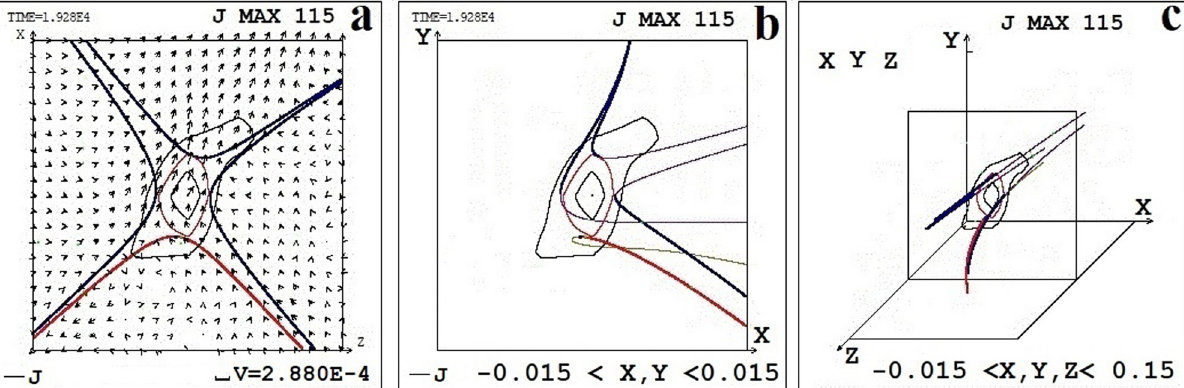
Figure 9: The con fi guration of the magnetic fi eld and the plasma fl ow in a region with a linear size of 0.03 ( 12 mm ) in the center of which the 115th maximum of the current density is located. Graphical representations are similar to those shown in Figure 8, but for di ff erent J max ( magnetic con fi gurations a – c for J max 115 )